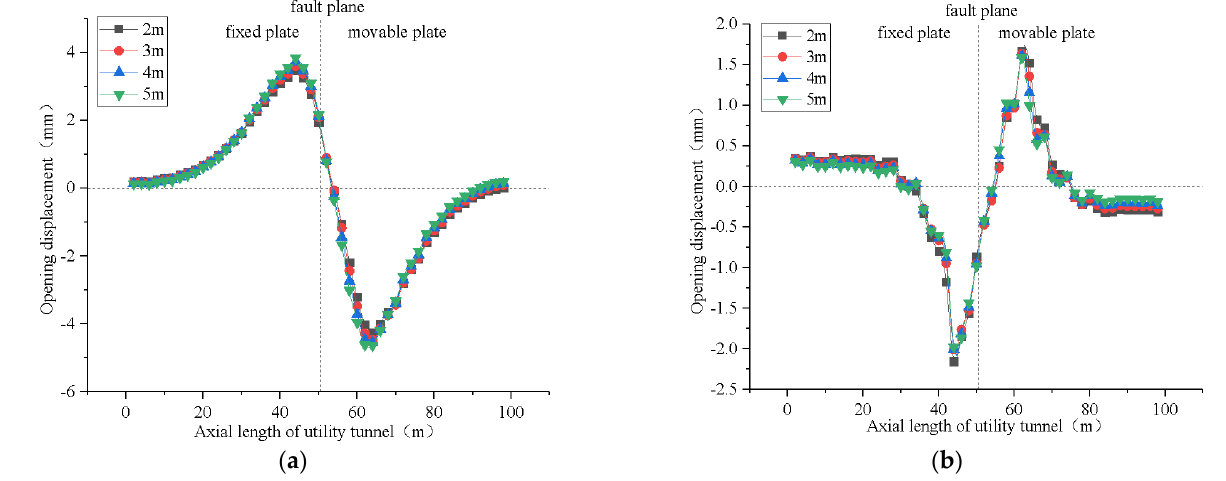
Figure 12. Distribution curves of the longitudinal horizontal opening displacement. ( a ) Roof ( b ) Floor.